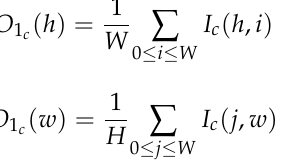
Table 2. Overall structure of ShuffleNetv2.